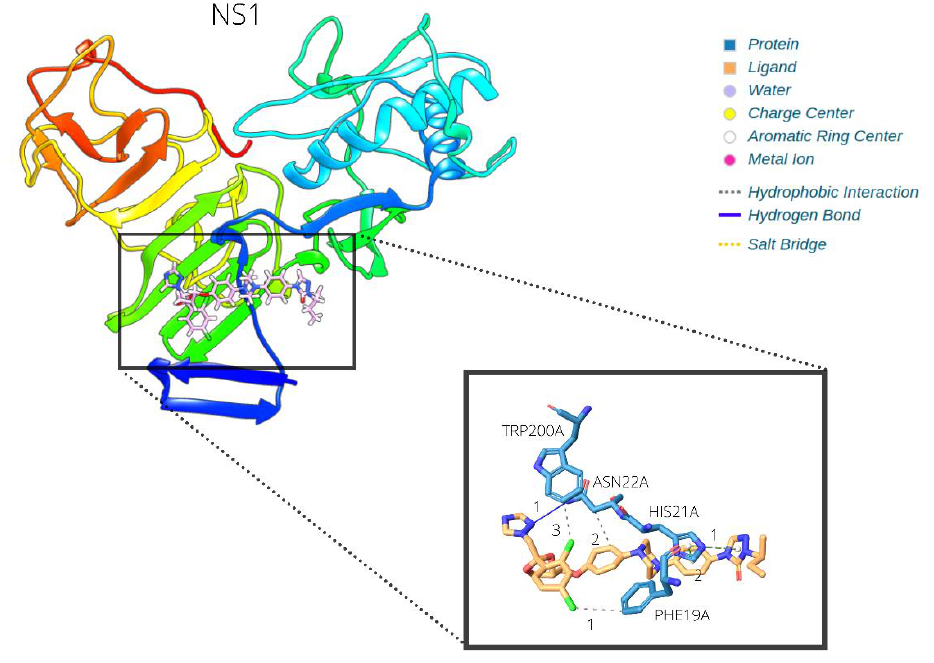
Figure 4. Itraconazole – NS1 interaction.